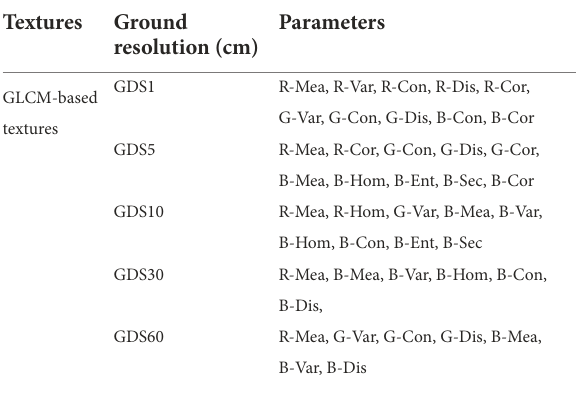
TABLE 1 Selected GLCM-based textures to estimate potato AGB.